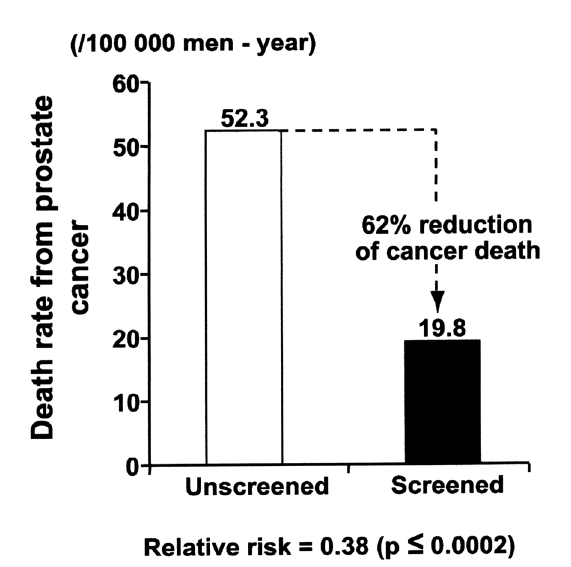
Figure 2 – Graphic demonstrating that PSA screening and con- sequently early diagnosis of prostate cancer at a localized stage resulted in a 62% reduction of prostate cancer death at 11 years of